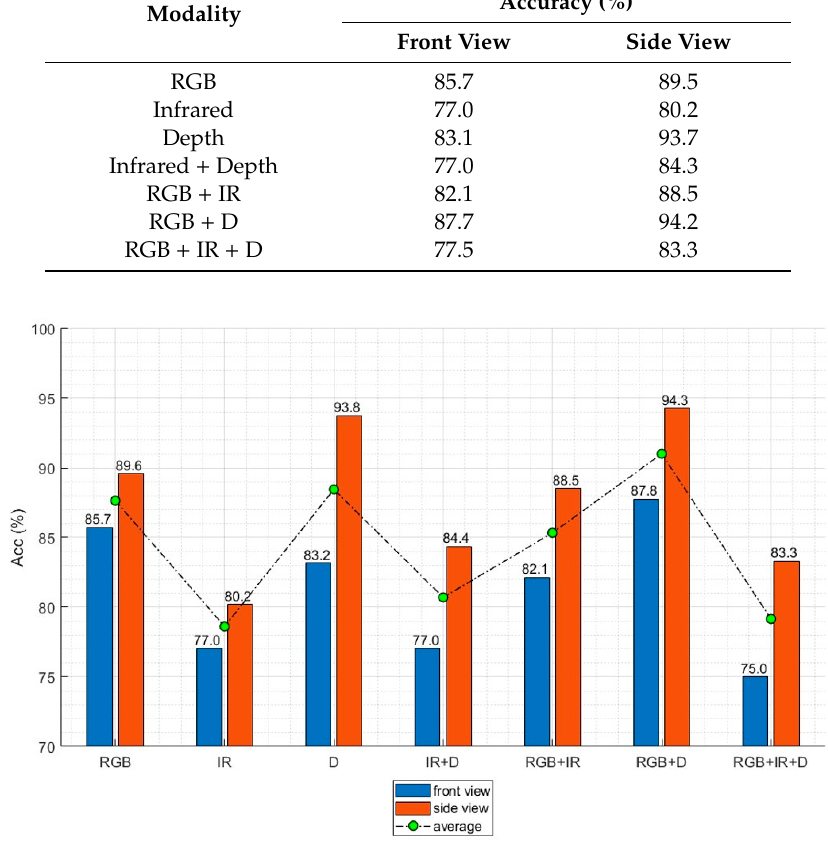
Figure 10. Recognition accuracy according to the image modality.